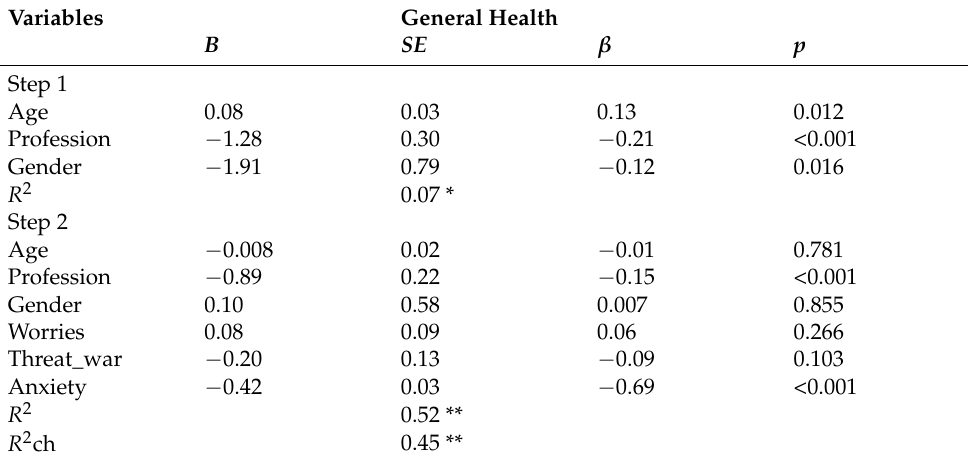
Table 4. Hierarchical linear regression analysis examining the role of worries, threats, and anxiety in prediction of general